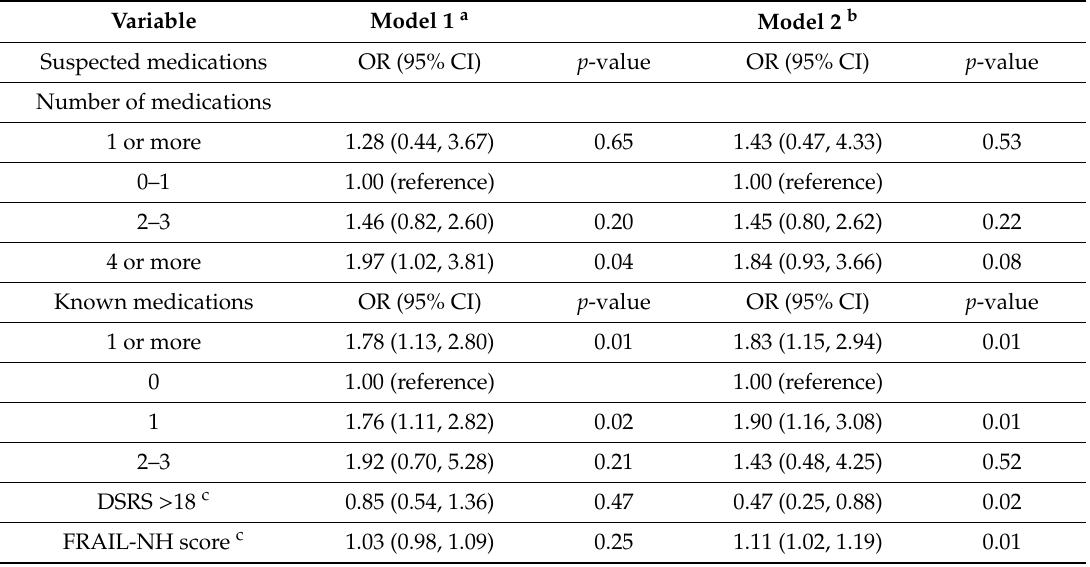
Table 2. Odds ratios and 95% confidence intervals for the association between systemic medications, dementia, and dry